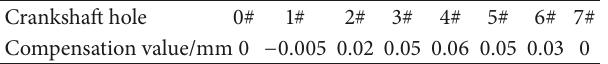
Figure 6: The design deflection curve of crankshaft hole of engine block. Table 1: Machining compensation value of crankshaft hole